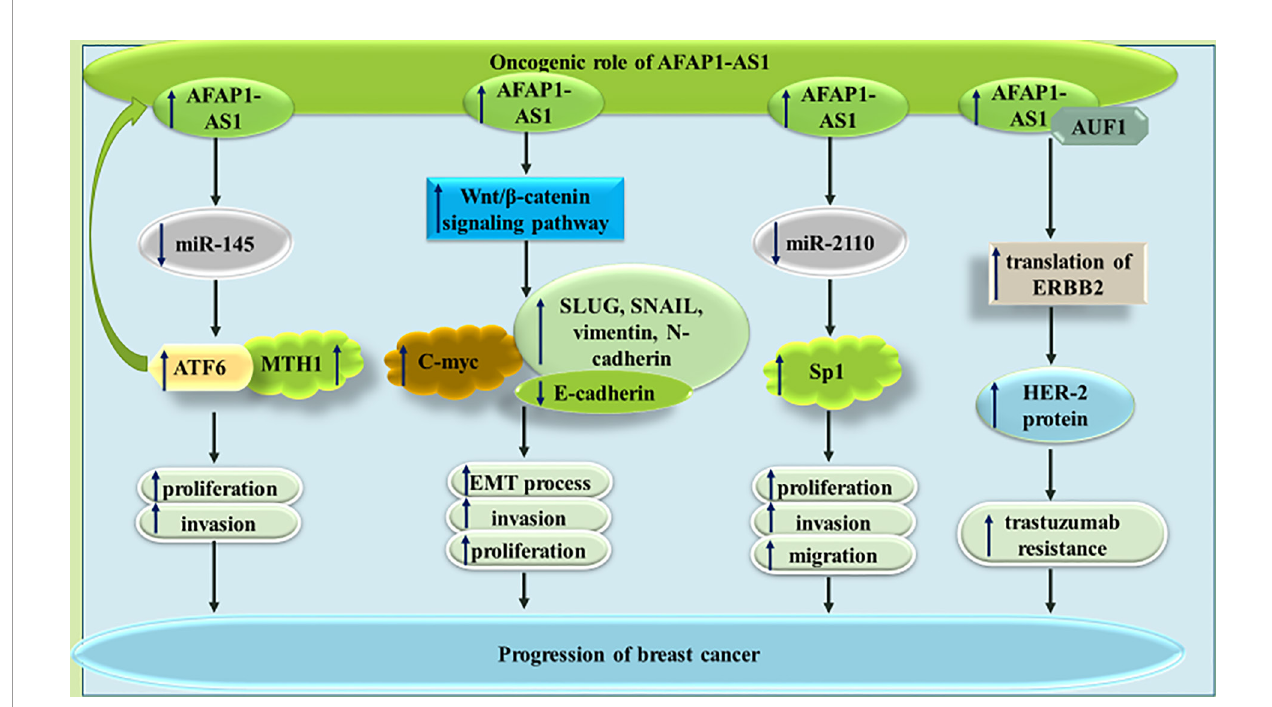
FIGURE 3 | The impact of AFAP1-AS1 in breast cancer progression and resistance to therapy. In addition to increasing cell proliferation and invasion, this lncRNA can increase expression of Her-2 protein, thus increasing resistance to trastuzumab.